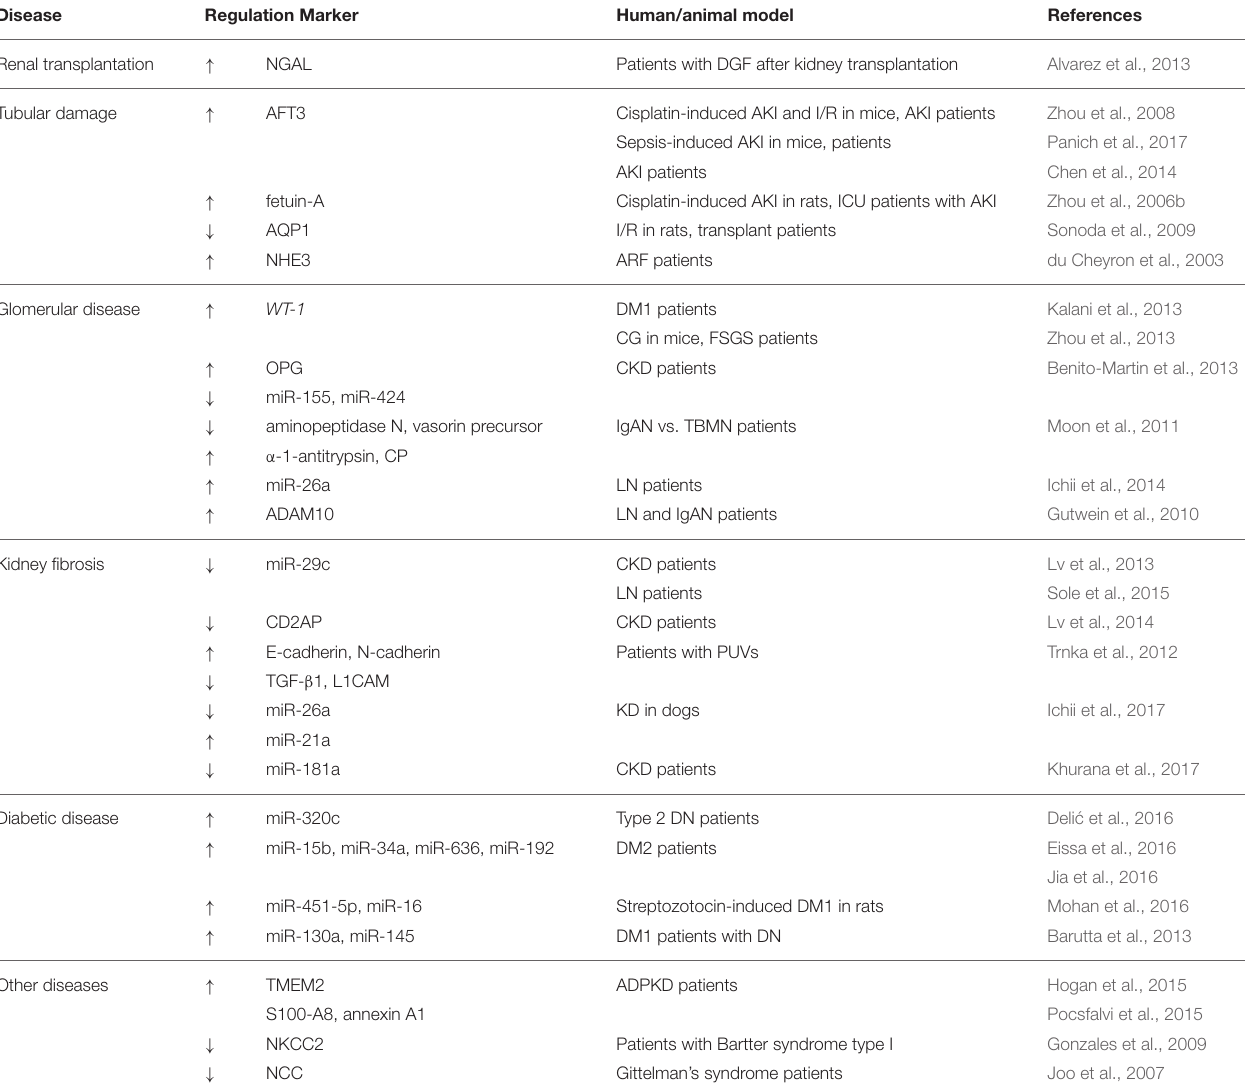
TABLE 2 | Summary of candidate uEV biomarkers for renal non-tumoral